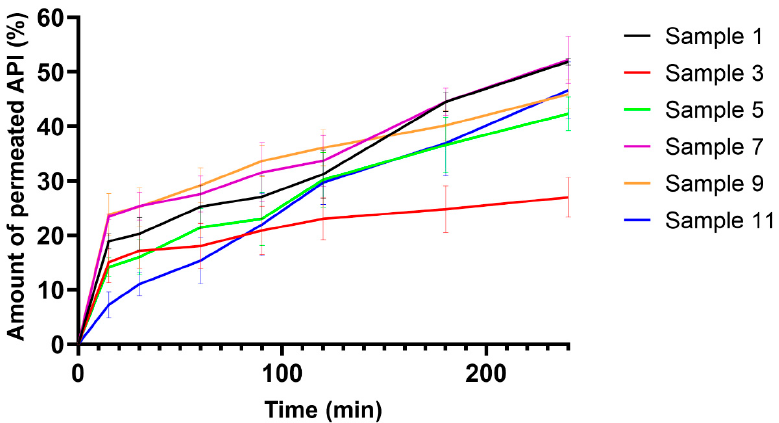
Figure 5 . Permeation curves of polymer films on artificial membrane ( n = 6)